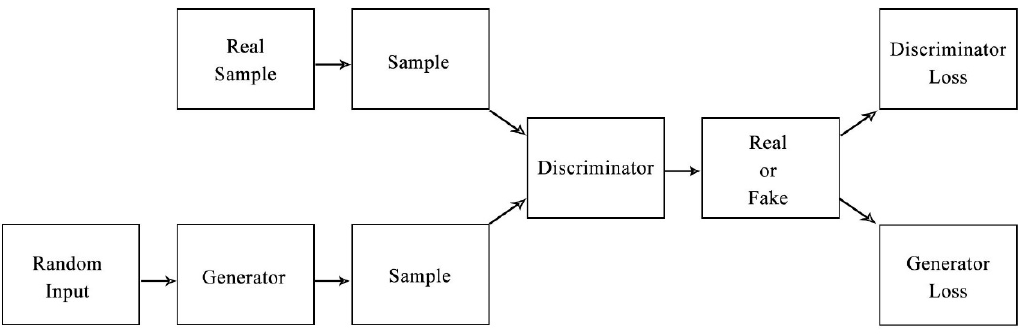
Figure 1. The architecture of GAN.